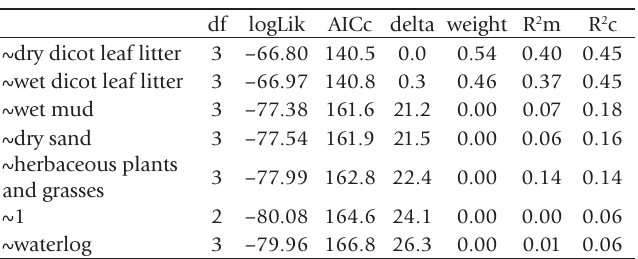
Table 2. Effect of specific environmental variables on total abun- dance of pygmy